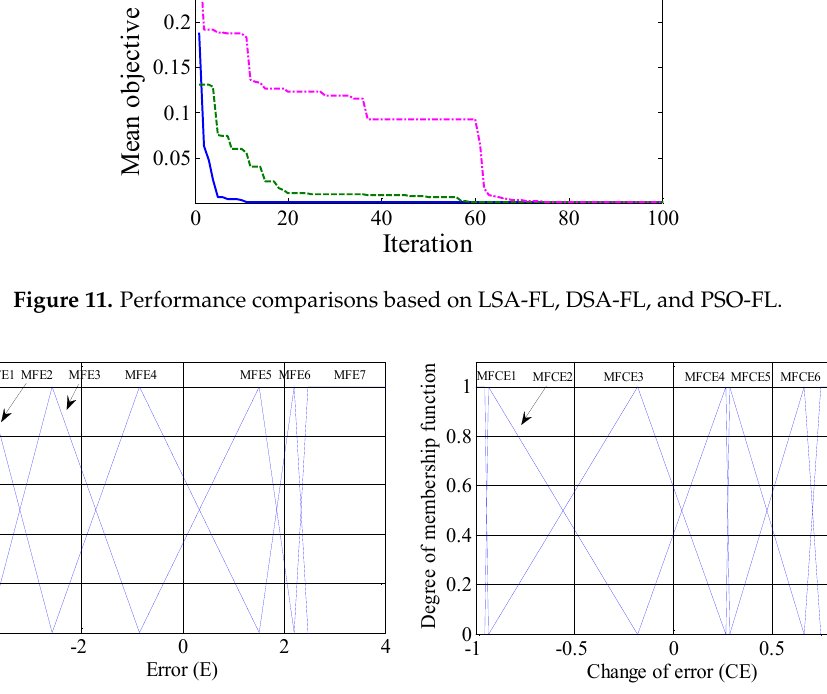
Figure 12. Optimized MFs of ( a ) E and ( b ) CE using LSA.